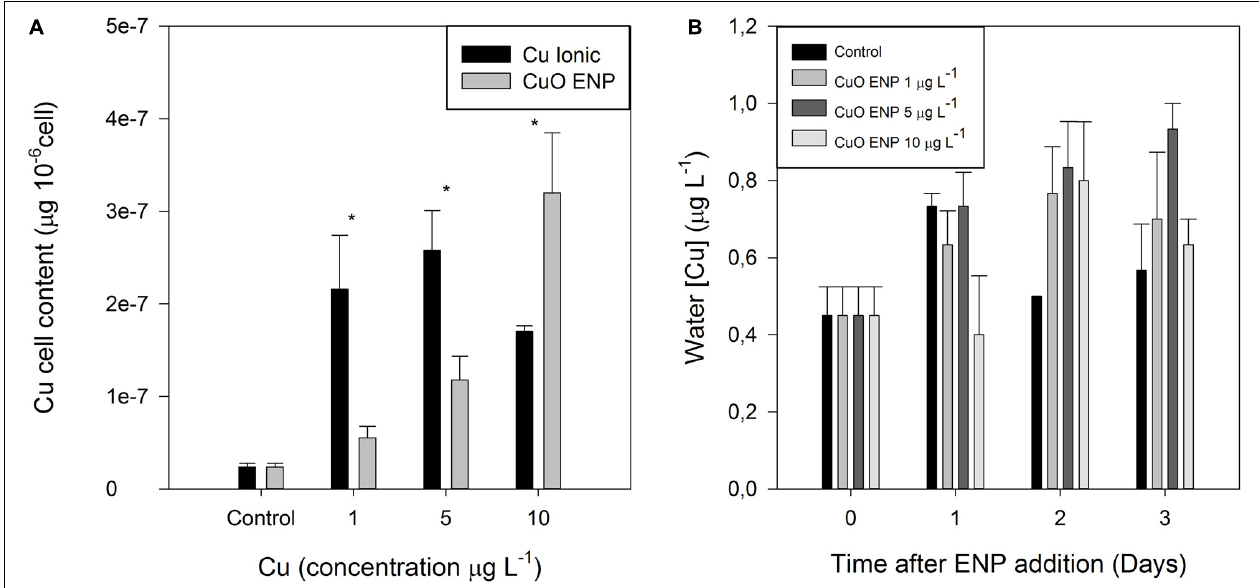
FIGURE 2 | (A) Copper cell content in P. tricornutum ( µ g Cu 10 - 6 cells) after 3 days of exposure to increasing ionic Cu (black bars) and CuO ENP (gray bars) concentrations and (B) Copper release ( µ g L - 1 ) from CuO ENP in f/2 medium under experimental concentrations and conditions (average ± standard deviation, N = 3, *above bars indicate significant differences compared with the control at p <